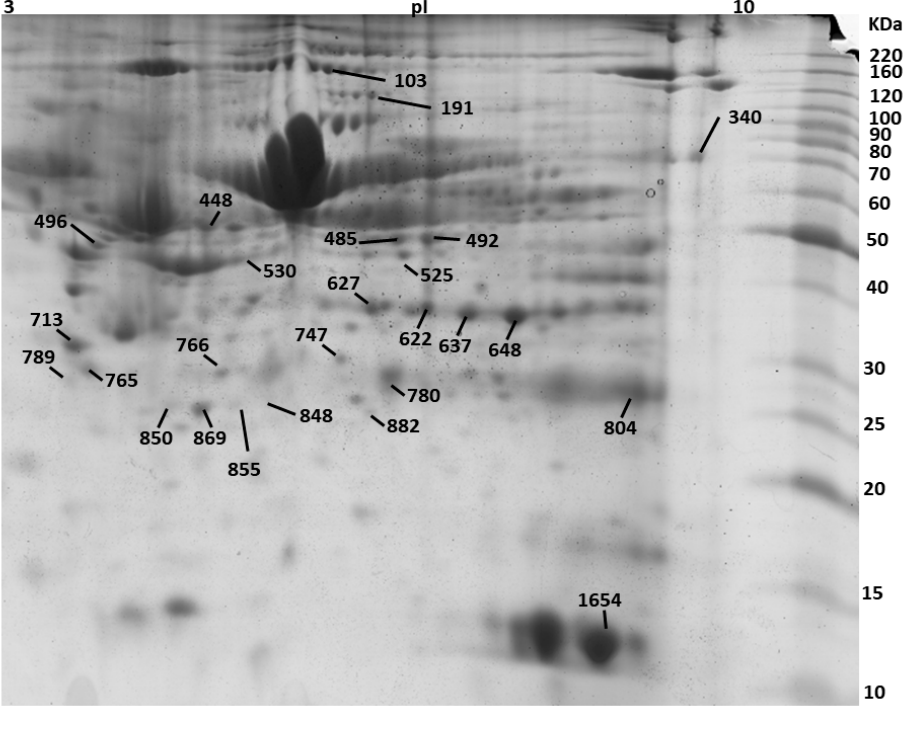
Figure 4. Selected gel spots from a representative 2DE gel.